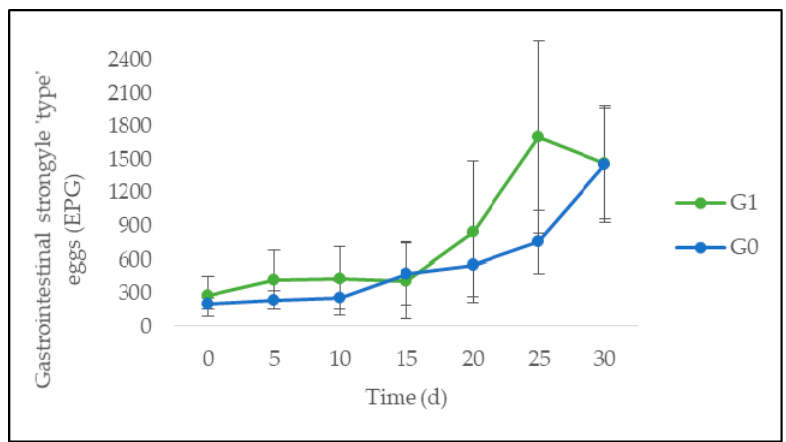
Figure 4. Evolution of gastrointestinal strongyle-“type” eggs per gram of feces (EPG) of sheep fed on C. nlemfuensis hay alone (G0) or G. ulmifolia foliage and C. nlemfuensis hay (G1). d: day.